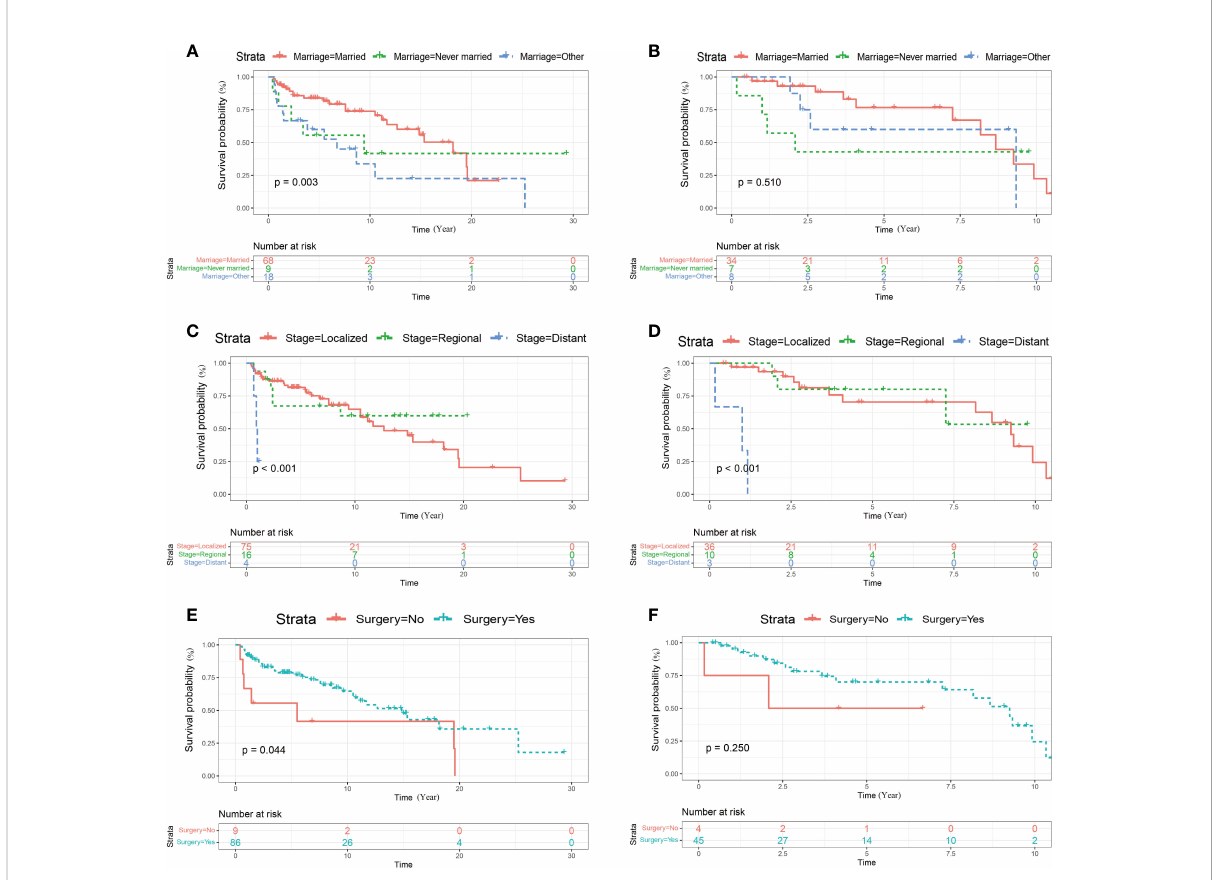
FIGURE 3 Kaplan – Meier curves of OS for patients with penoscrotal EMPD strati fi ed by marital status (A, B) , SEER historic stage A (C, D) and surgery (E, F) in the training cohort and validation cohort